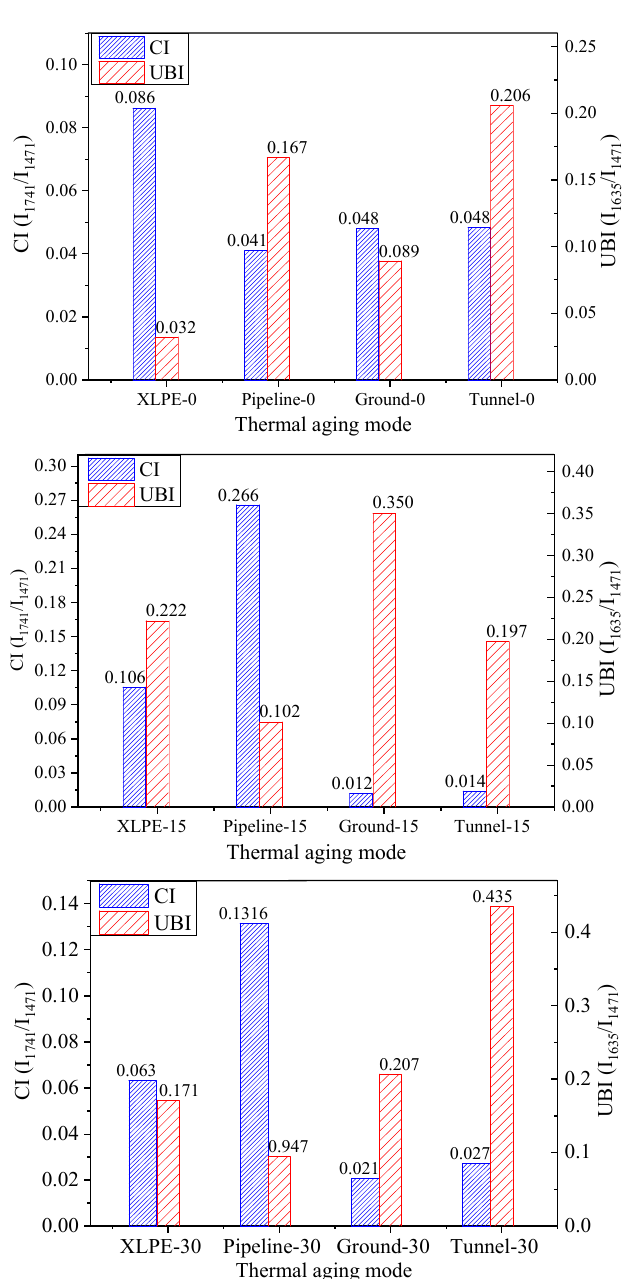
Figure 6. Carbonyl index, CI , and unsaturated band index, UBI , of the untreated specimens and the treated specimens under thermal aging of three different laying modes.